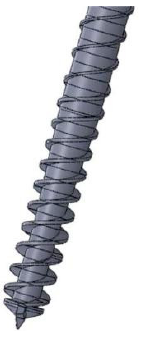
Figure 3. Drill tool model after discretization.